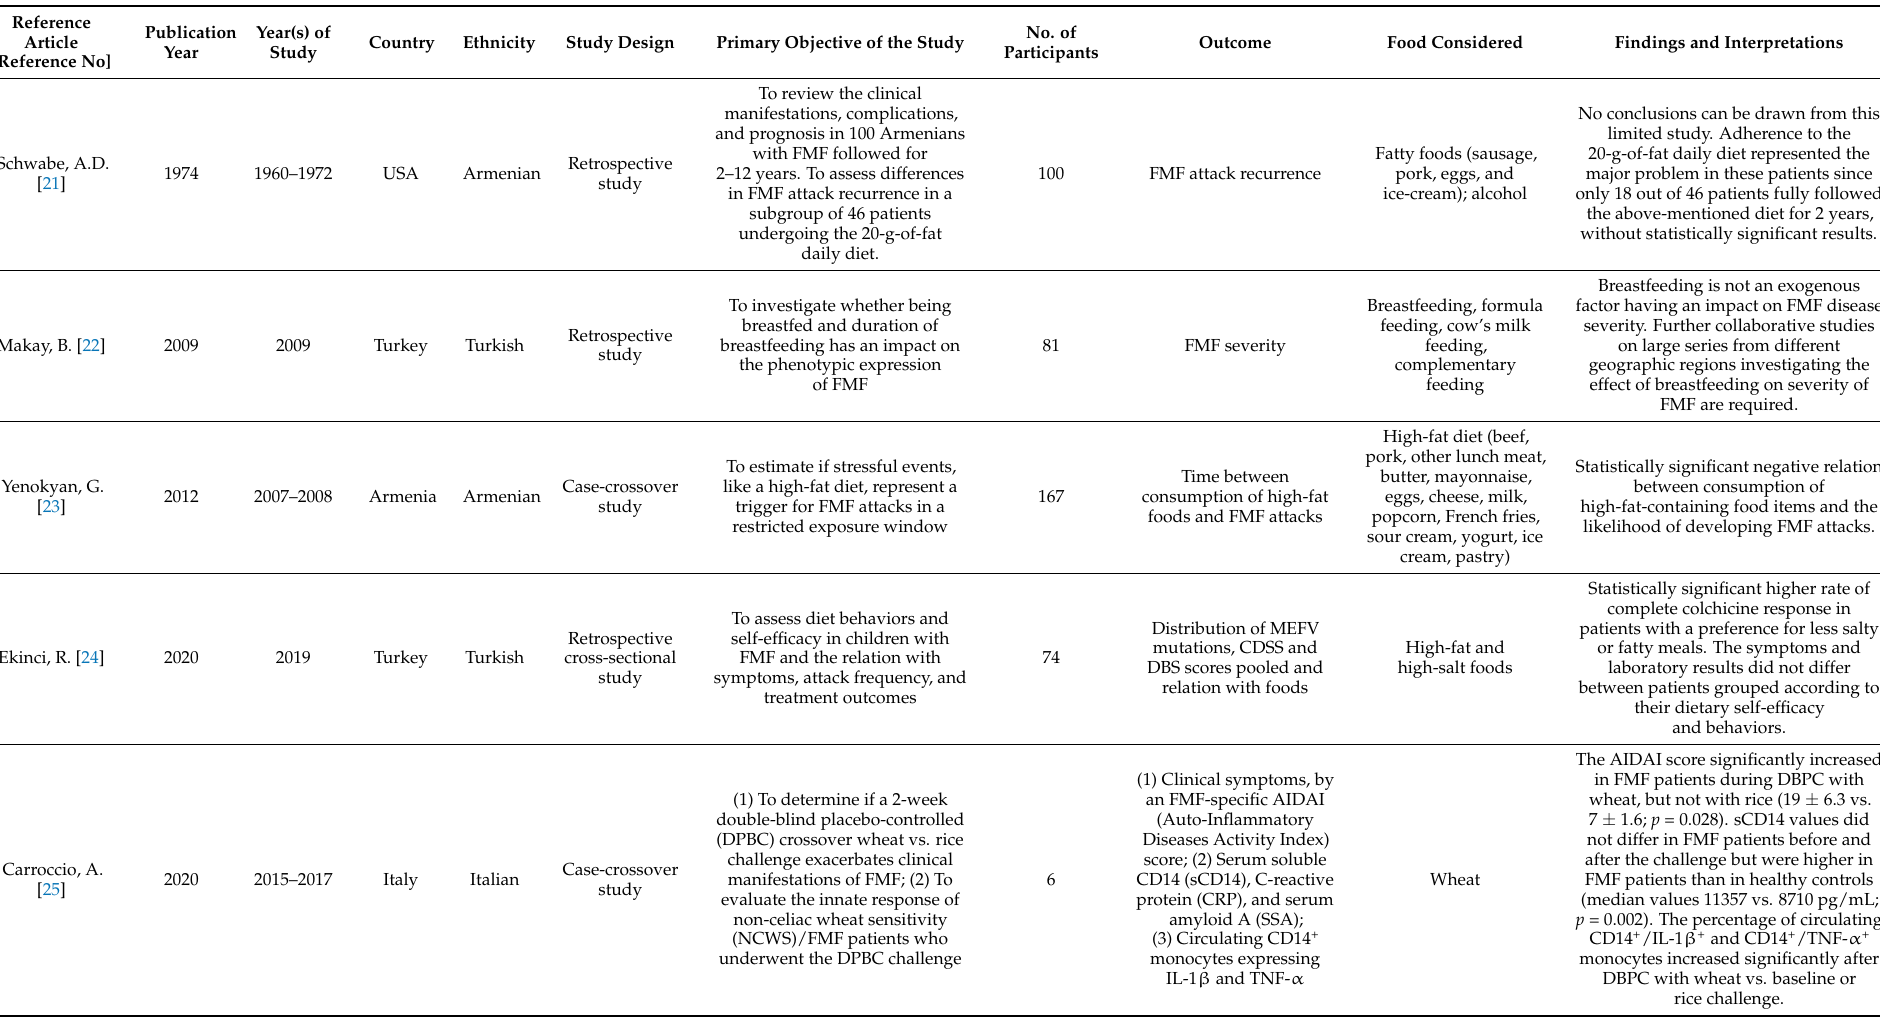
Table 1. Characteristics and main results of the included studies (reported in order of publication